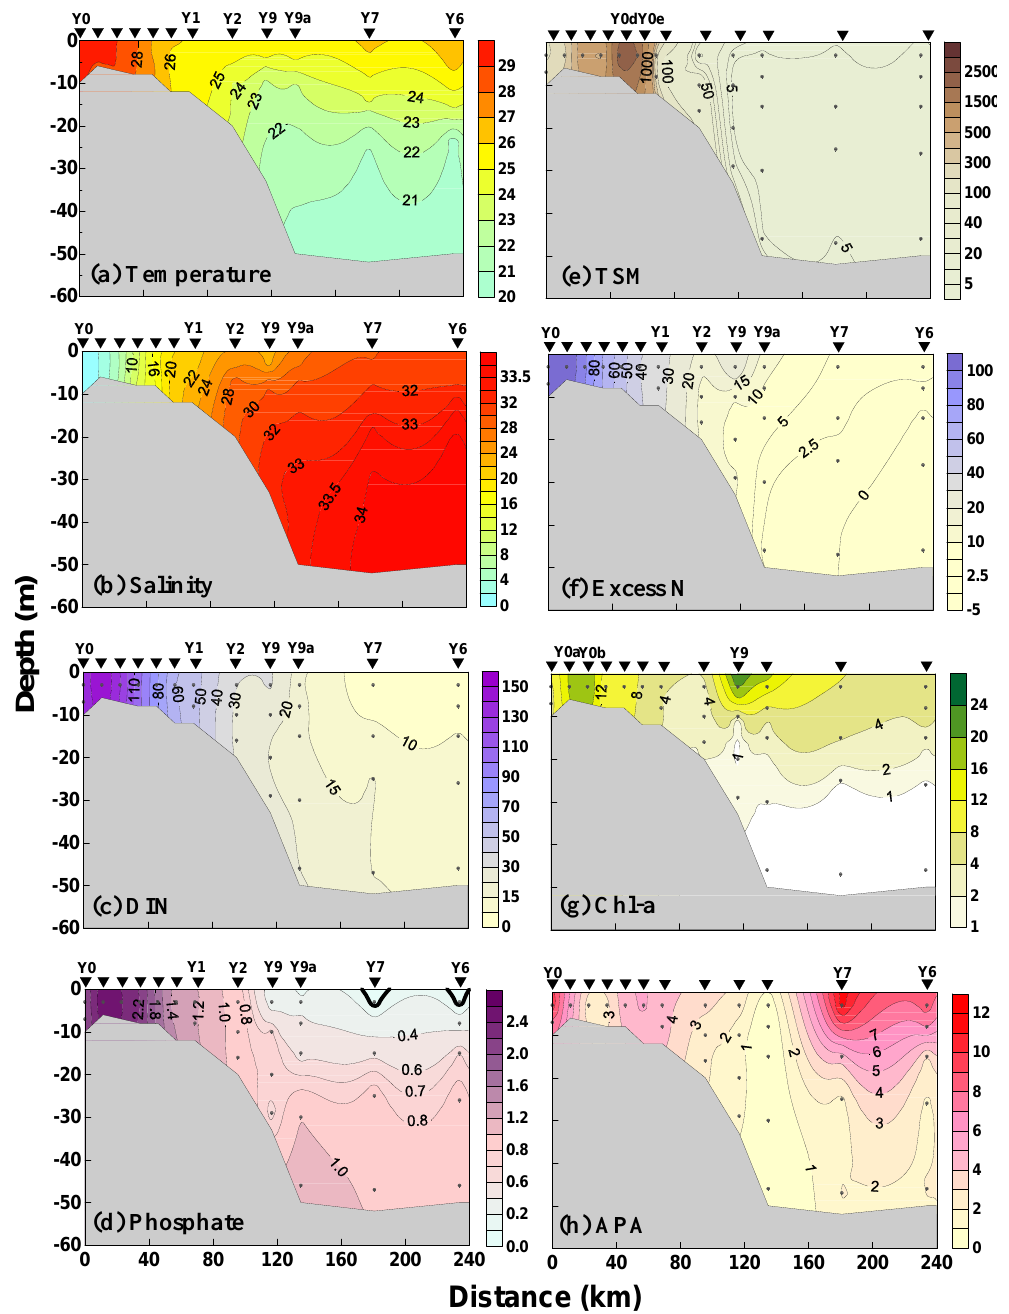
Fig. 3. Vertical distributions of parameters along CJ transect. (a) Water temperature ( ◦ C), (b) salinity, (c) DIN (µM), (d) phosphate (µM), (e) TSM (mgL − 1 ), (f) excess N (µM), (g) Chl a (mgChlm − 3 ), and (h) APA (nMh − 1 ). The dots denote the discrete sampling over various depths. The inverted triangles denote the